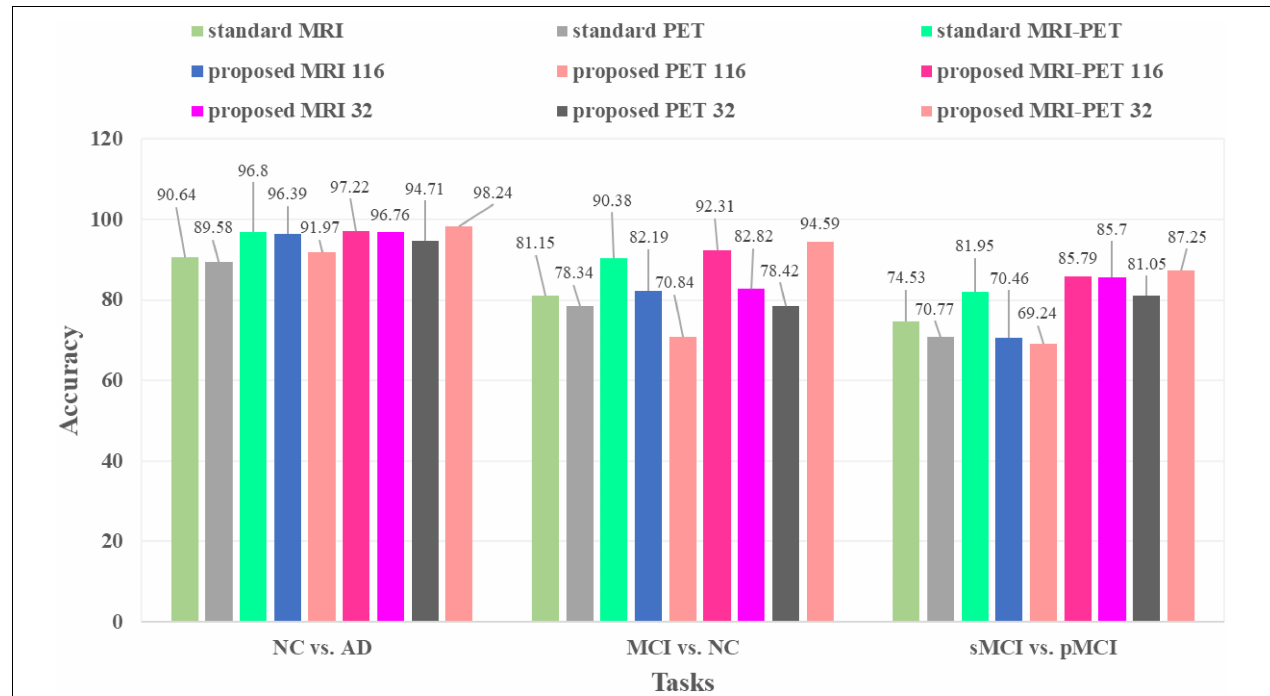
FIGURE 5 | Classification accuracies comparison between the standard and the proposed method in three different tasks.